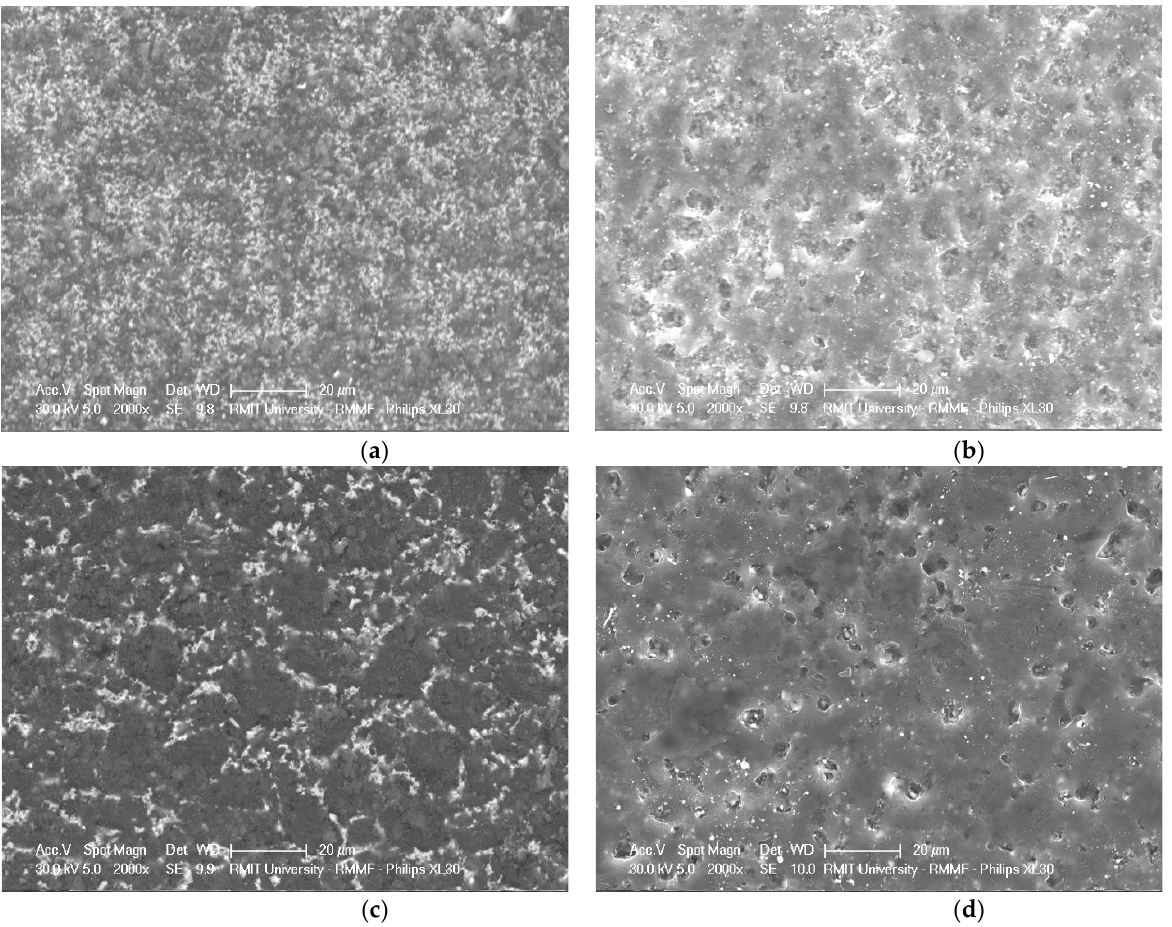
Figure 3. The flank face of PCD inserts after grinding: ( a ) CTB002, abrasive grinding, ( b ) CTB002, EDG, ( c ) CTM302, abrasive grinding, ( d ) CTM302, EDG.